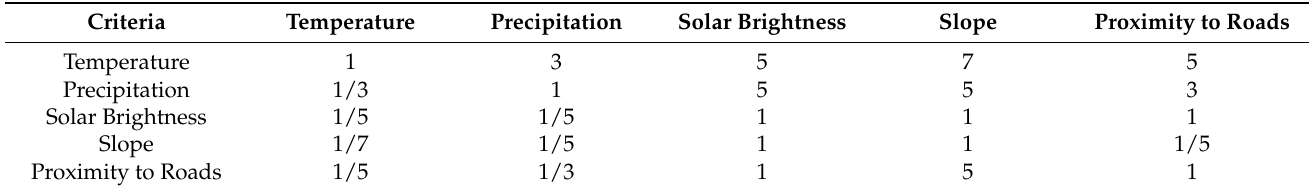
Table 5. Paired comparison matrix with domain